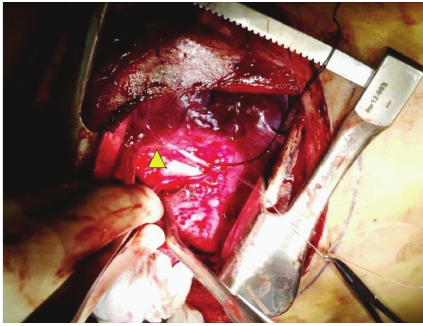
Figure 3: Cross field selective one-lung ventilation with a single- lumen endobronchial tube via the